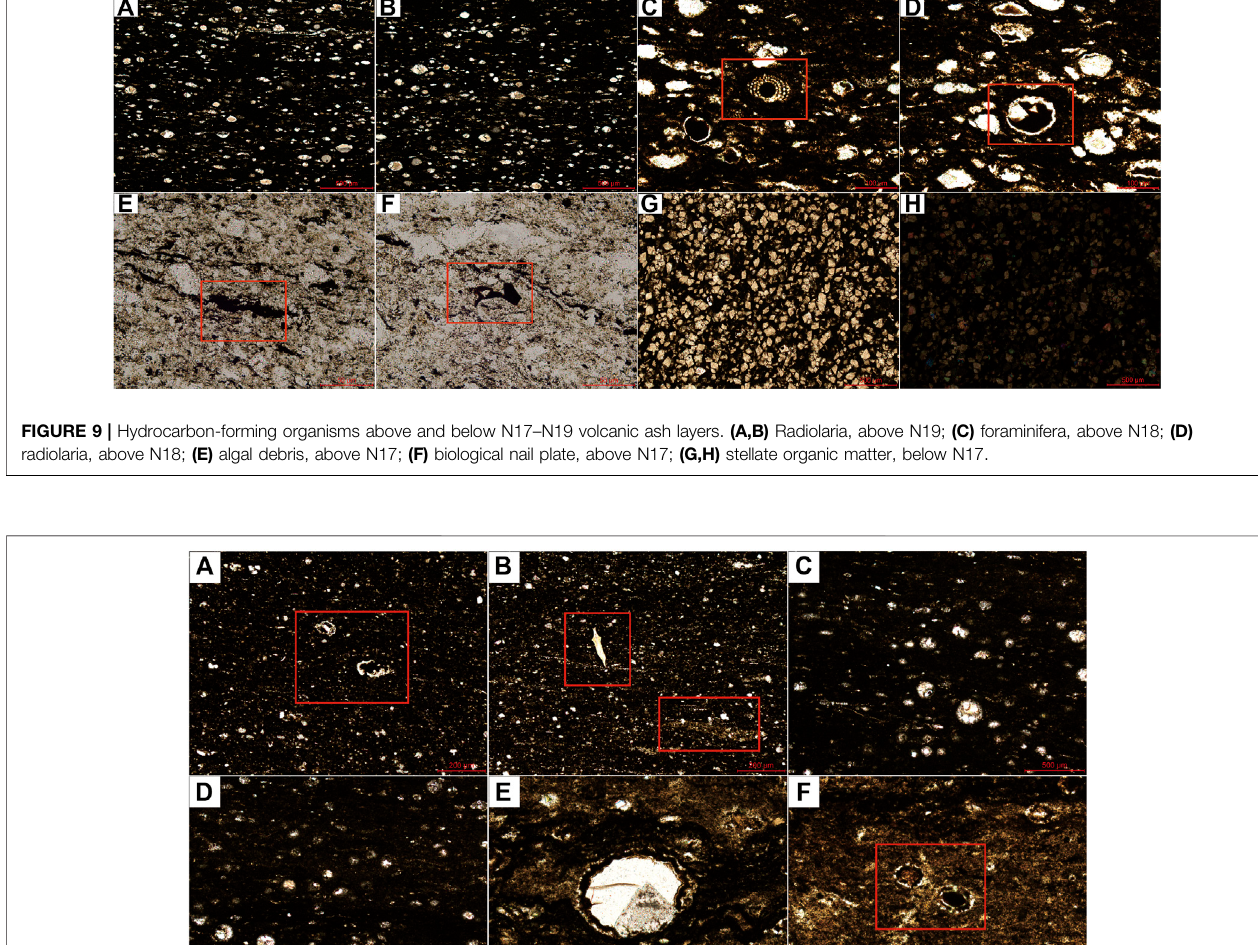
Frontiers in Earth Science |